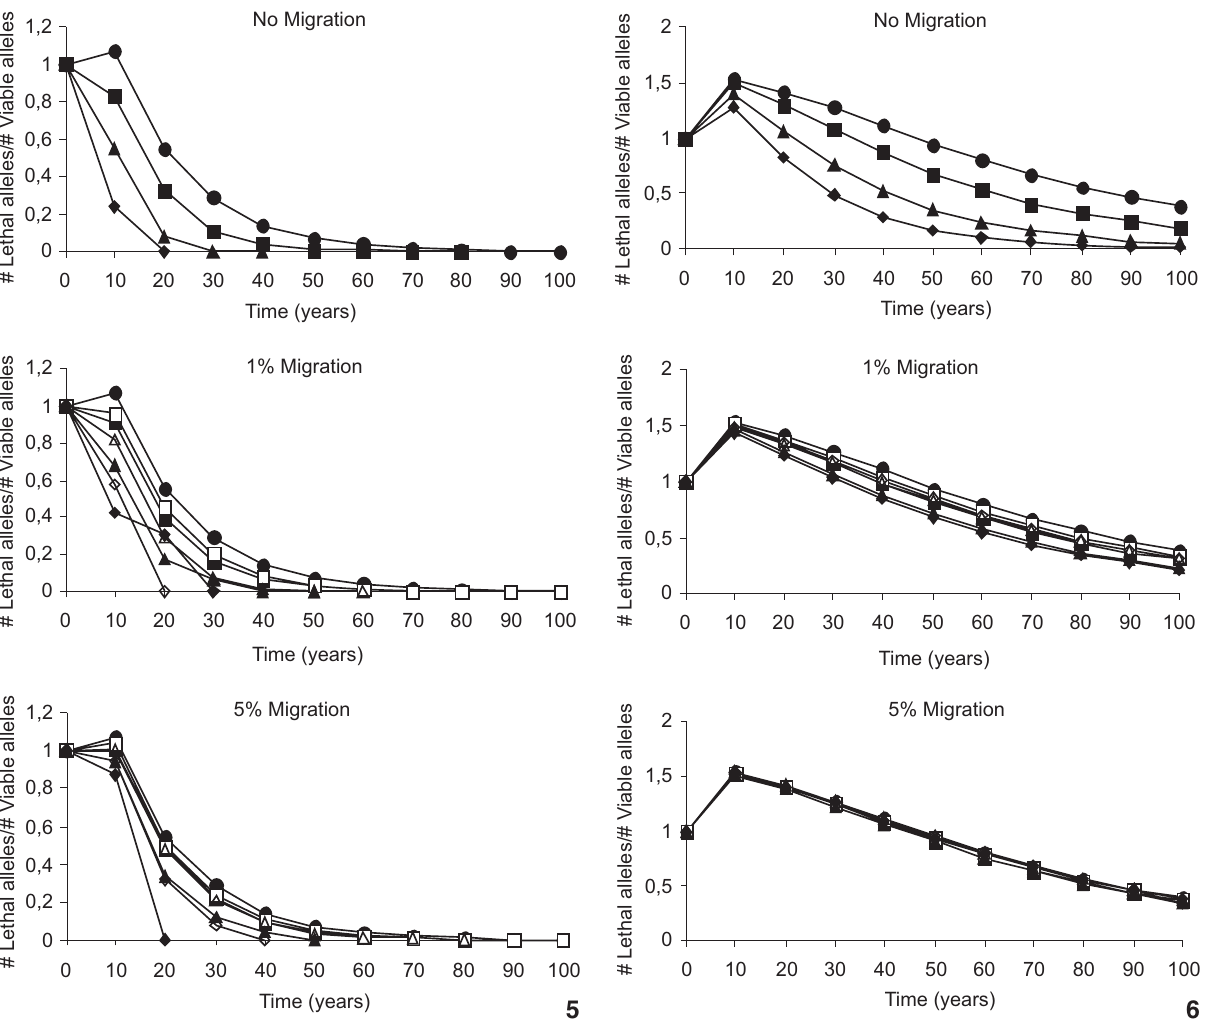
Figure 5. Reduction in the genetic load over 100 years from metapopulations of M. paraguayanus with carrying capacity of 100 (5) and 2000 (6), divided into 1 ( (cid:2) ), 2 ( (cid:3) ), 5 ( (cid:2) ) or 10 ( (cid:4) ) subpopulations connected by different migration rates (0%, 1% or 5%) and by equal dispersal by both sexes (white) and male-biased dispersal